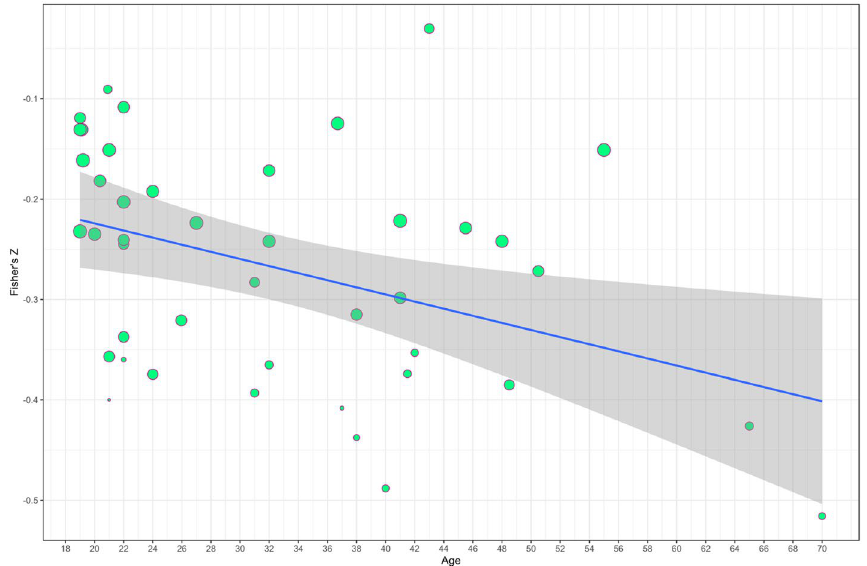
Figure 3. Regression of effect size (Fisher’s Z ) on age. Line of best fit plus confidence interval, bubbles show study